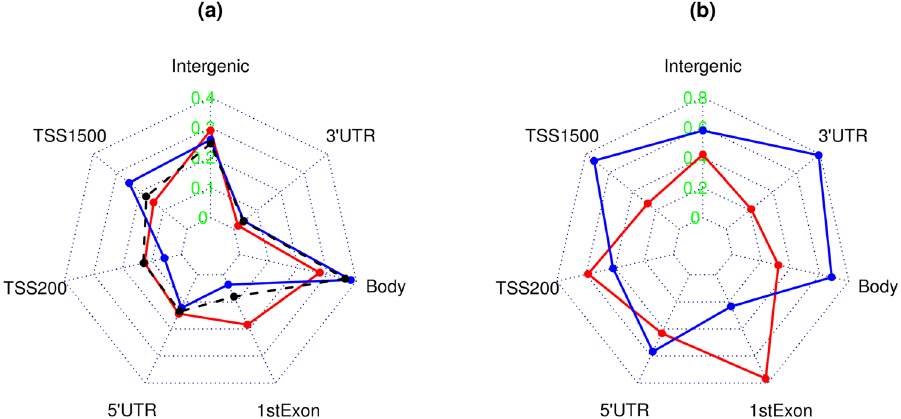
Figure 2. Starplots showing ( a ) proportionality of gene regions for the age-methylated (red) and demethylation (blue) CpGs; and ( b ) region-specific proportion of age-methylated (red) and demethylated (blue) CpGs in all double-replicated CpGs in the gene region.